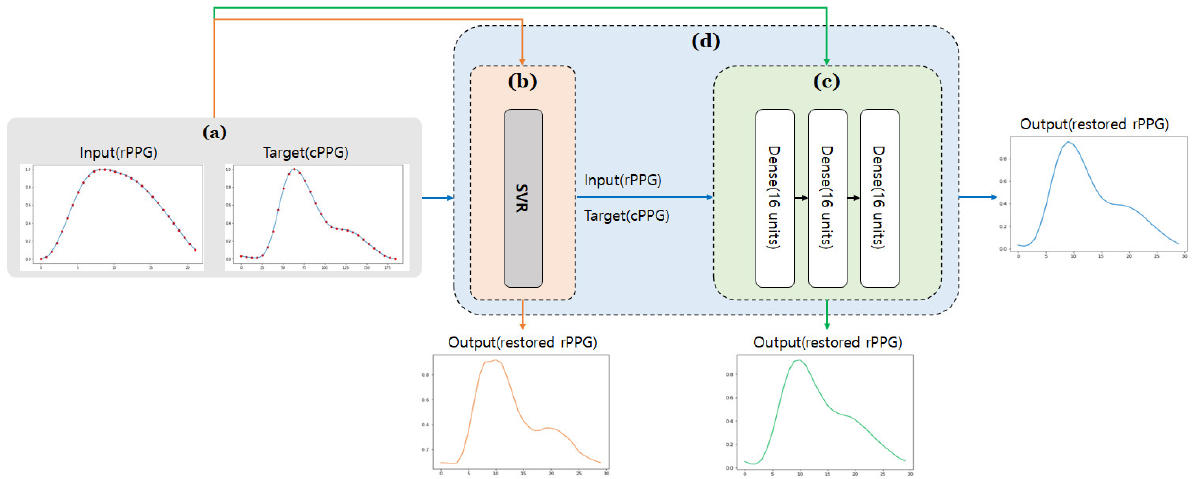
Figure 6. Flow chart of the proposed rPPG restoration method: ( a ) Training data through the corresponding points of rPPG and cPPG; ( b ) SVR-based restoration model (explained in Section 2.3.1); ( c ) a restoration model based on deep learning (explained in Section 2.3.2); ( d ) a restoration model using SVR and deep learning together (explained in Section 2.3.3).